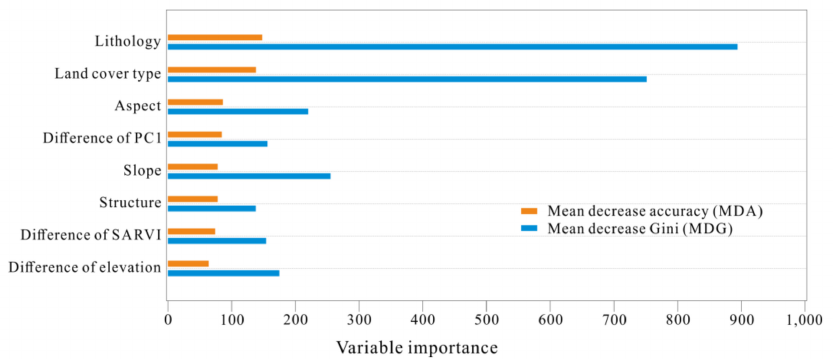
Figure 14. Ranking of predictive factors’ contribution to RF-based prediction